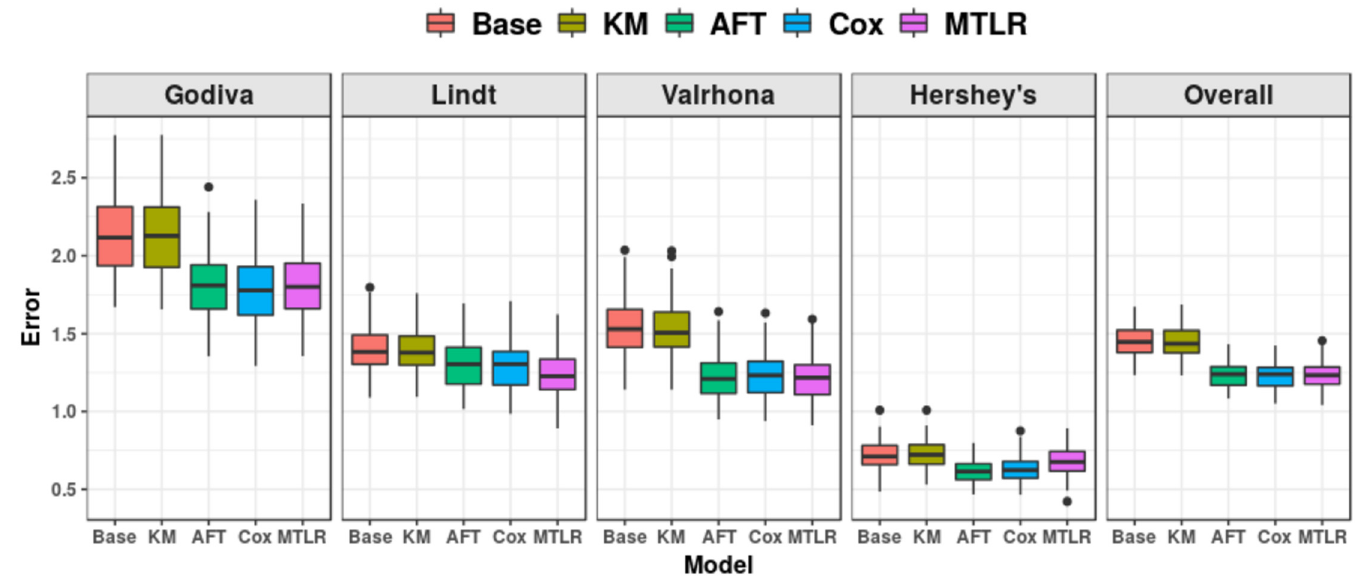
Fig 9. Mean absolute error (MAE) over ten-times repeated ten-fold CV.